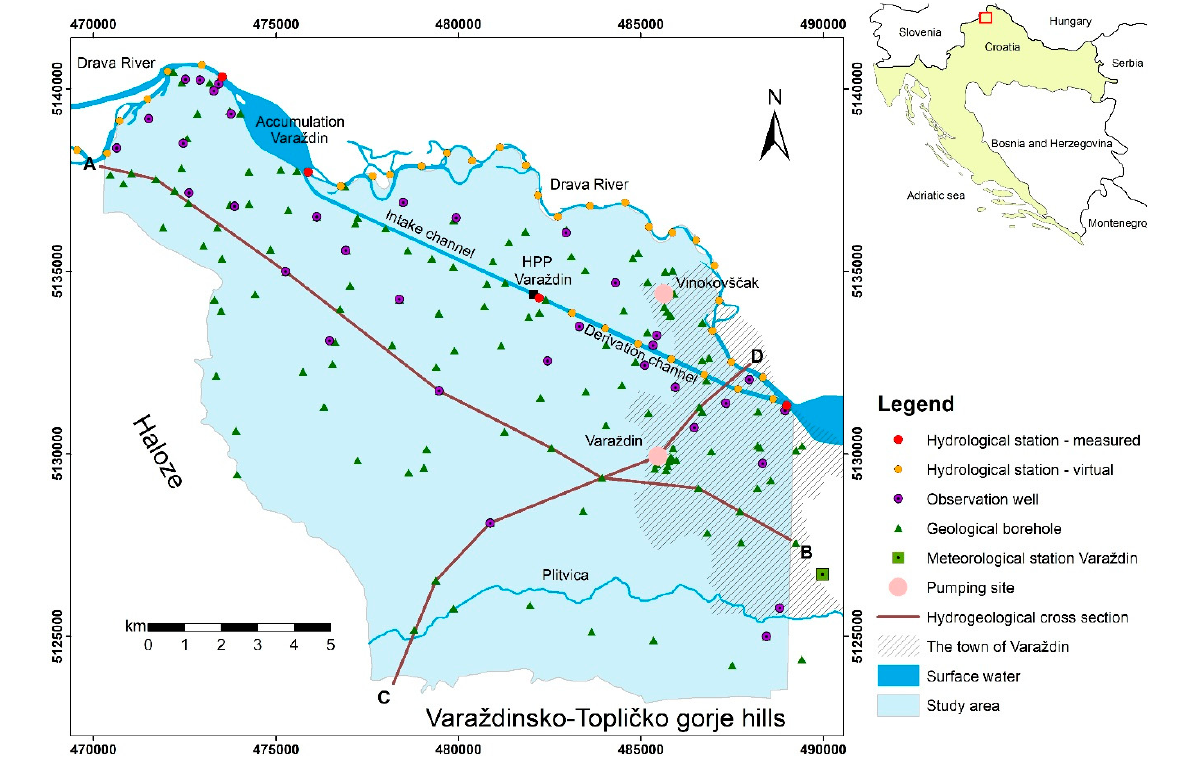
Figure 1. Geographical position of the study area with locations of surface water bodies, hydrological stations, meteorological station, pumping sites, observation wells and geological boreholes used for conceptualization of the Varaždin alluvial aquifer; the transects A–B and C–D correspond to hydrogeological cross-sections shown in Figure 4.